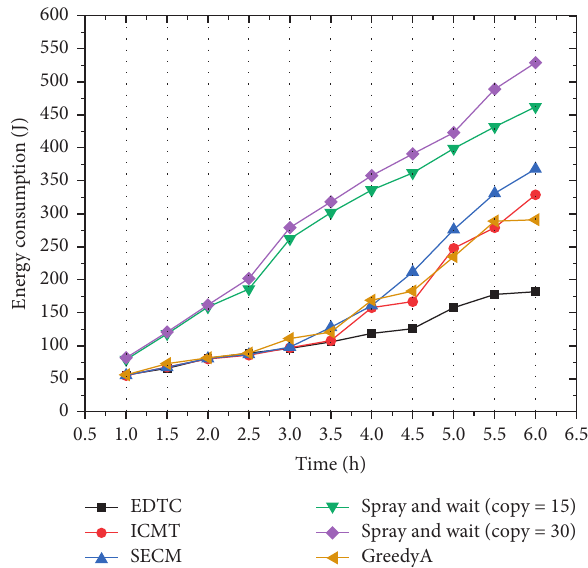
Figure 14: Relationship between energy consumption and